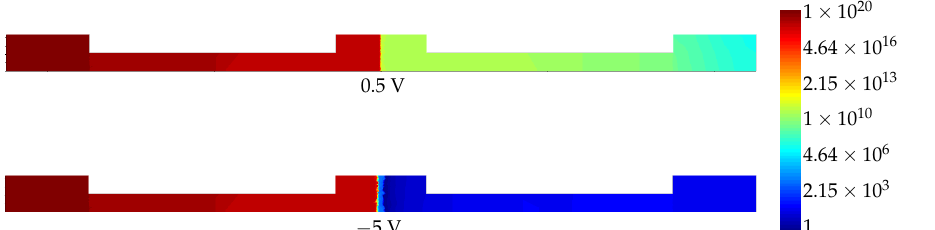
Figure 3. Distributions of electrons in the cross-section of the rib waveguide for different applied voltage values.